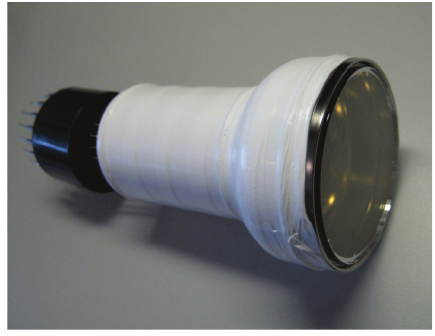
Figure 11: The Hamamatsu R11410-10.